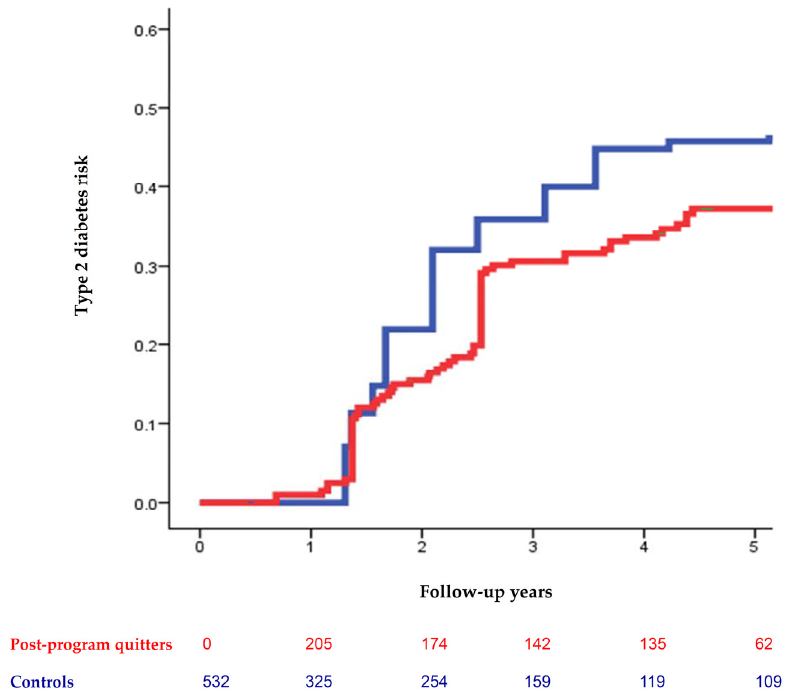
Figure 2. Long-term effect of the post-program abstinence on type 2 diabetes risk in the time-varying analysis. Table 2. Factors for long-term glycemic outcomes among prediabetic smokers in the time-varying analysis ( n =